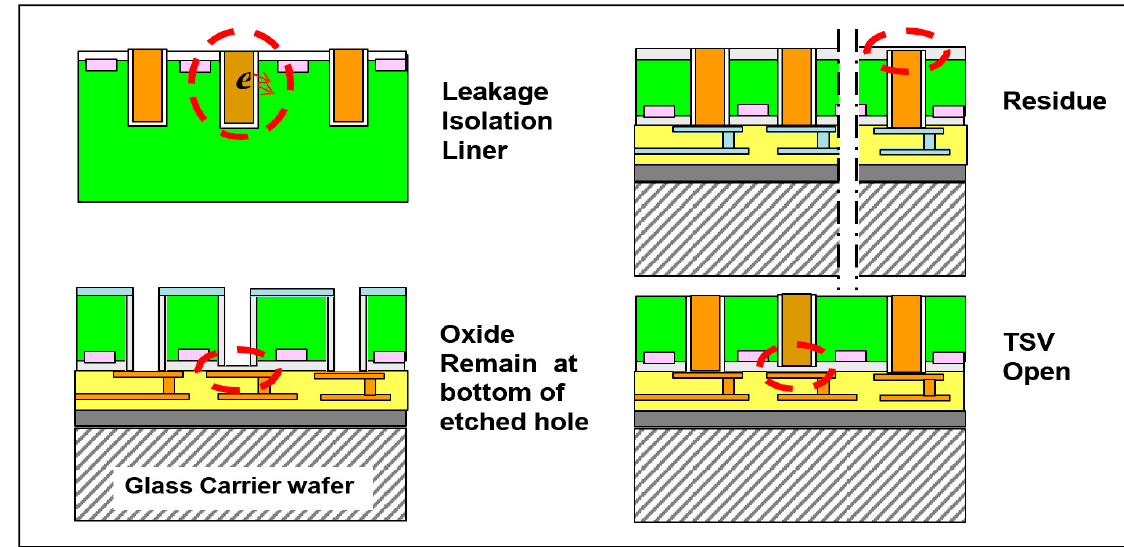
Figure 16. Sample TSV open defect due to left over oxide at bottom of etched hole.